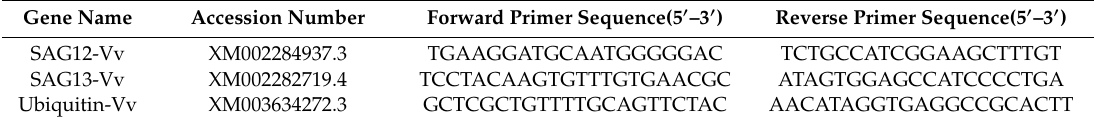
Table 1. The primer sequences of SAGs for